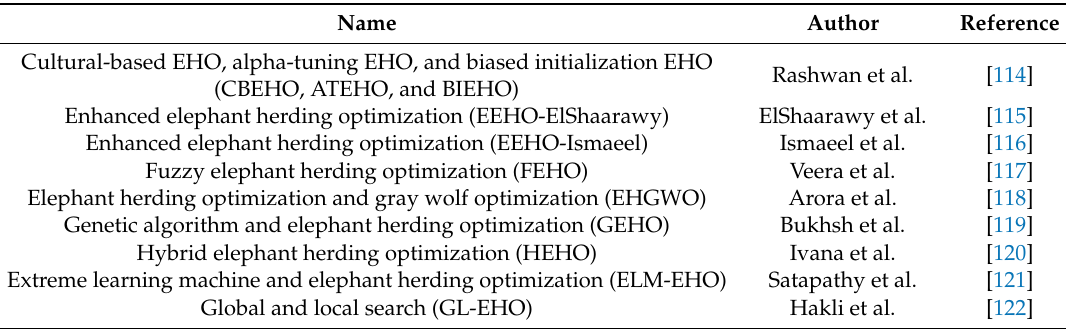
Table 2. The hybrid EHO